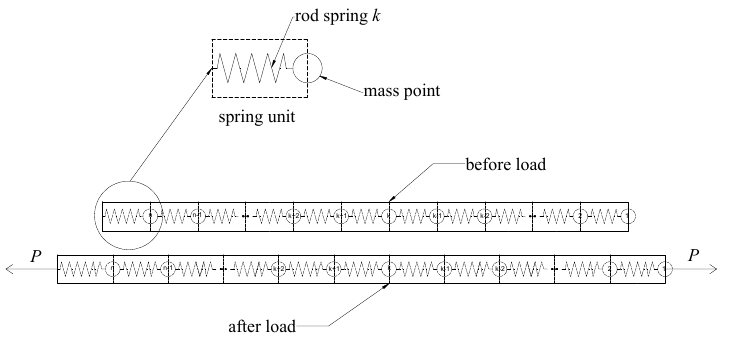
Figure 1. Schematic diagram of discretization of free rod.